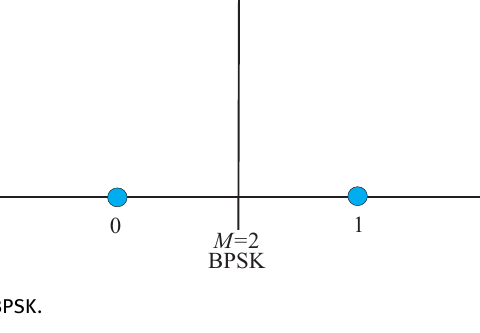
Figure 9: Signal space diagram of